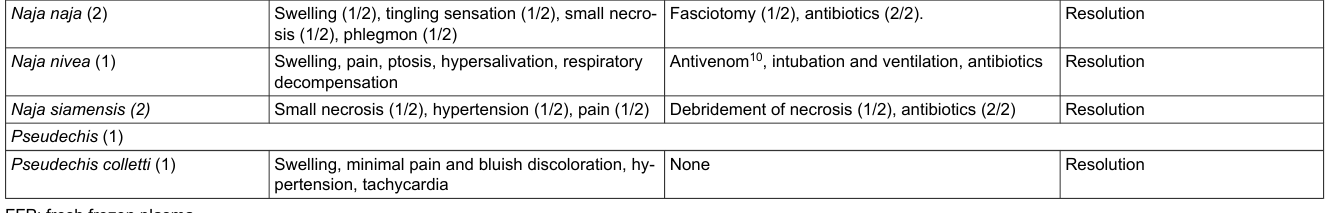
FFP: fresh frozen plasma 1 Antivenom not